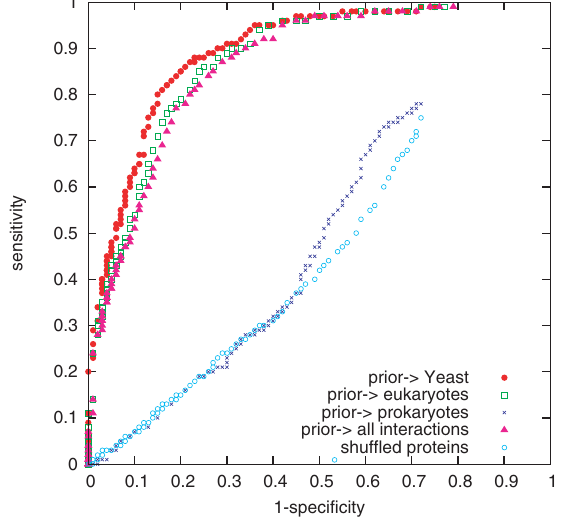
Figure 8. Performance by Using Different Prior Data Bases. ROC curves for the triangle rate score using upcast sets constructed, firstly, from yeast only, secondly, from all eukaryotes, thirdly, from all prokaryotes, and lastly, from all organisms. Randomly shuffled proteins are added for comparison.